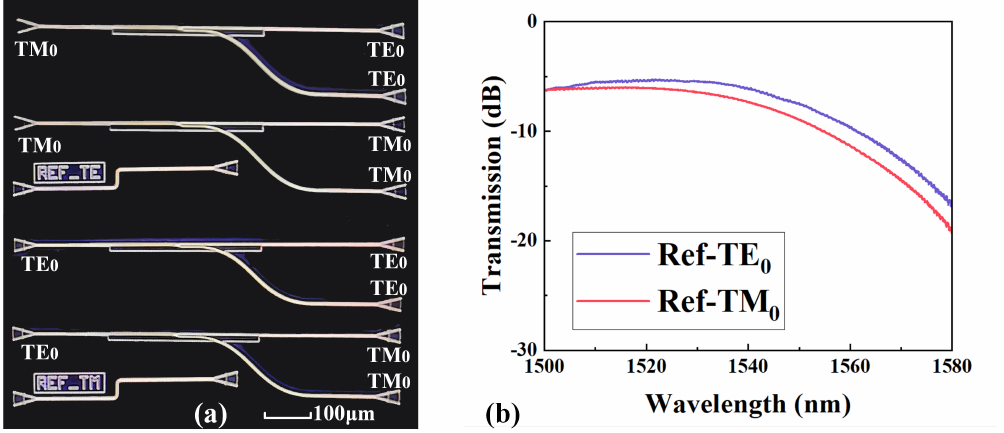
Figure 4. ( a ) Optical micrograph of the fabricated devices. ( b ) Transmission responses of the reference grating couplers.